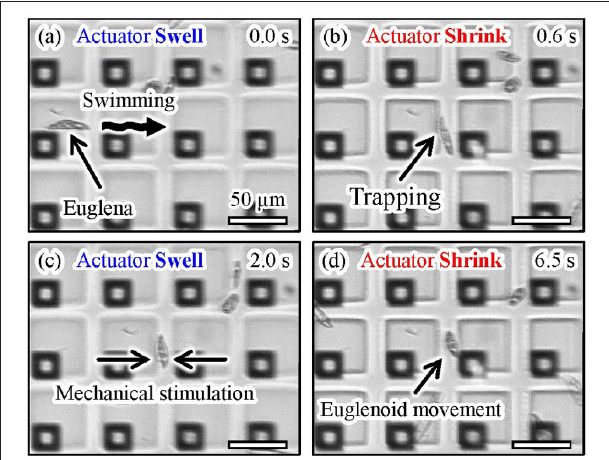
FIGURE 13 | Experimental images of trapping and mechanical stimulation of a Euglena cell. (a) A motile Euglena cell, (b) trapping of the Euglena cell by turning on the laser, (c) trapping and mechanical stimulation of the cell induced by turning off the laser, and (d) release of the Euglena cell by turning on the